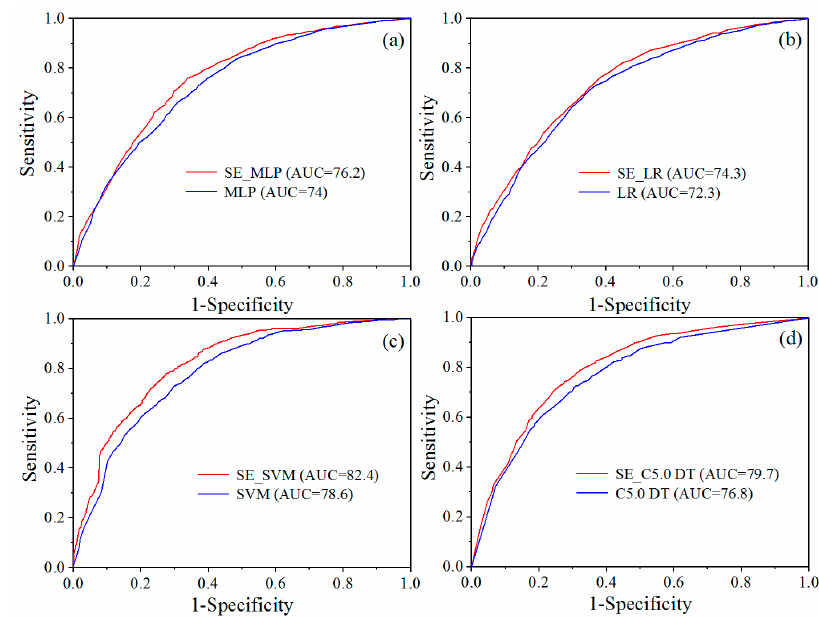
Figure 10. AUC value of each model with grid resolutions of 60 m: AUC values of SE_MLP and MLP models ( a ); AUC values of SE_LR and LR models ( b ); AUC values of SE_SVM and SVM models ( c ); AUC values of SE_C5.0 DT and C5.0 DT models ( d